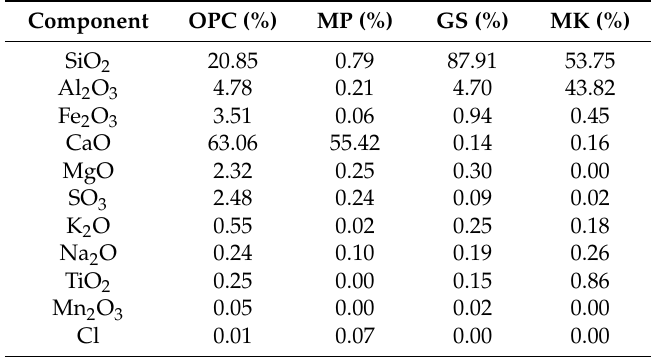
Table 1. Chemical composition of the cement, marble powder, green sand and